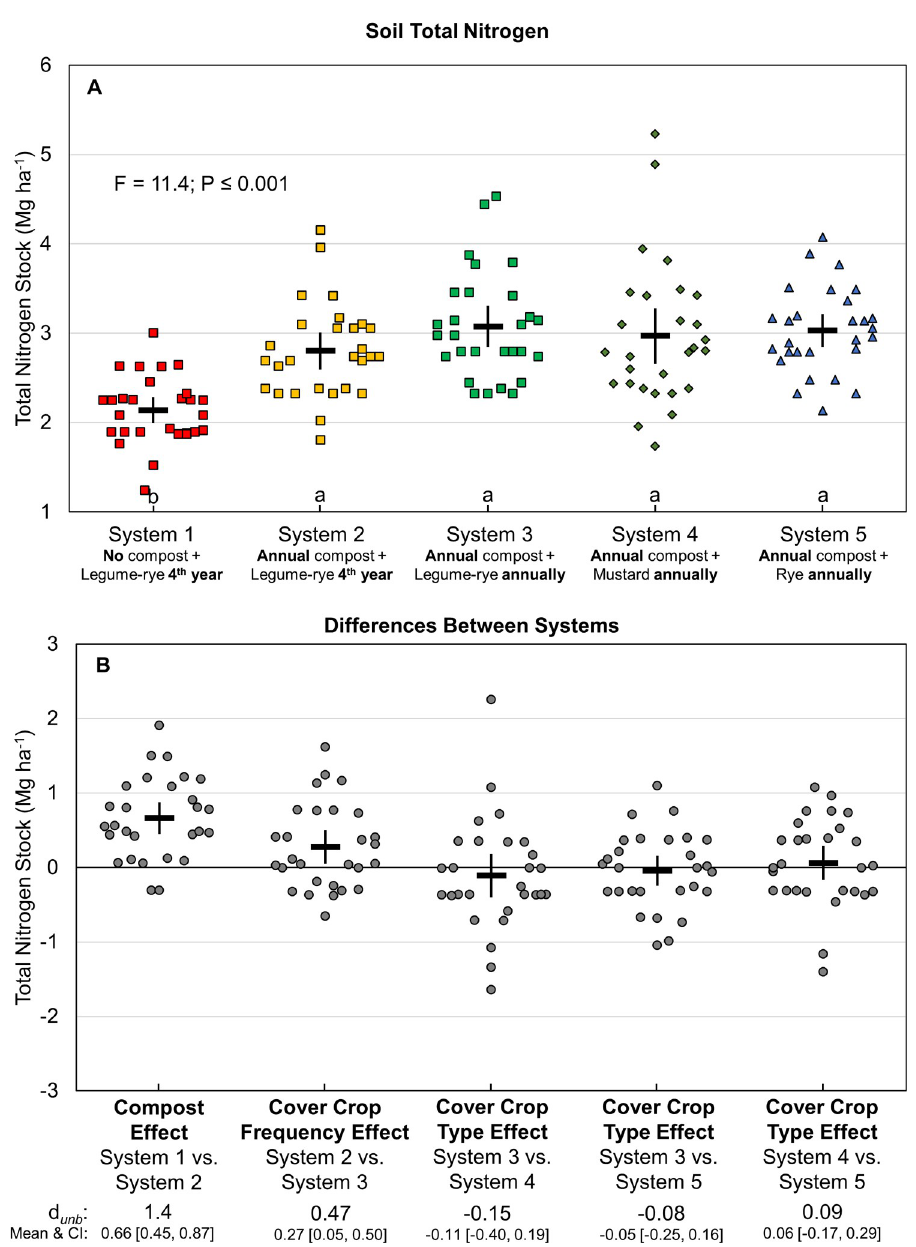
Fig 2. Soil total nitrogen stocks over seven years of vegetable production. Mean soil total nitrogen stocks (A) and mean paired differences between systems (B). Systems differed by annual compost additions, cover crop type and cover cropping frequency. Error bars are 95% confidence intervals (CI) around the mean (horizontal line). Samples were taken at the 0 to 30 cm depth after the 2 nd vegetable crop before winter fallow or cover cropping for years 1 to 7 when two vegetable crops were grown annually. Data points are the 4 replicates each year and are clustered around the mean so as not to obscure the mean and CI. Different lower-case letters above the x-axis indicate that means are significantly different based on the Tukey-Kramer adjusted family-wise error rate of P � 0.05. The standardized effect size (Cohen’s unbiased d , d unb ) is shown below the x-axis in plot